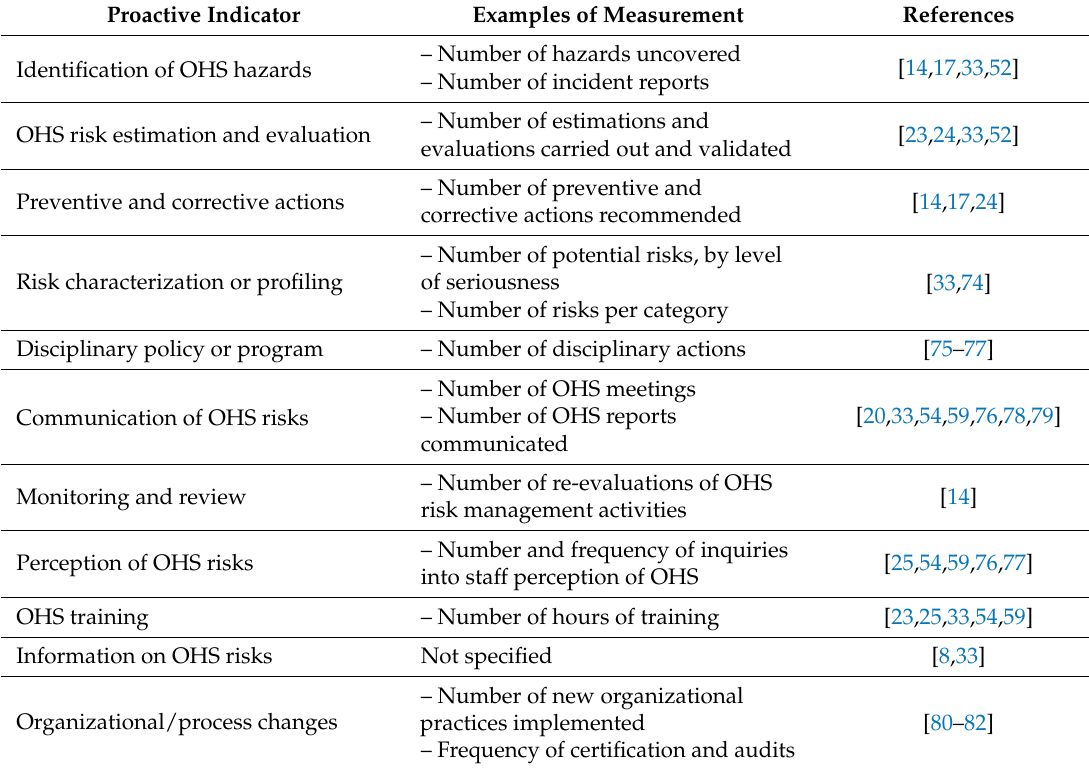
Table 1. The principal proactive measurable indicators in occupational health and safety